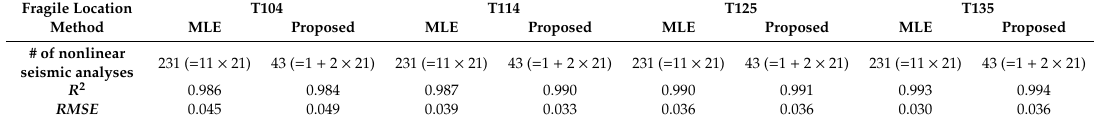
Figure 7. Piping seismic fragility curve regarding a limit state of seismically vulnerable T-joint T104.